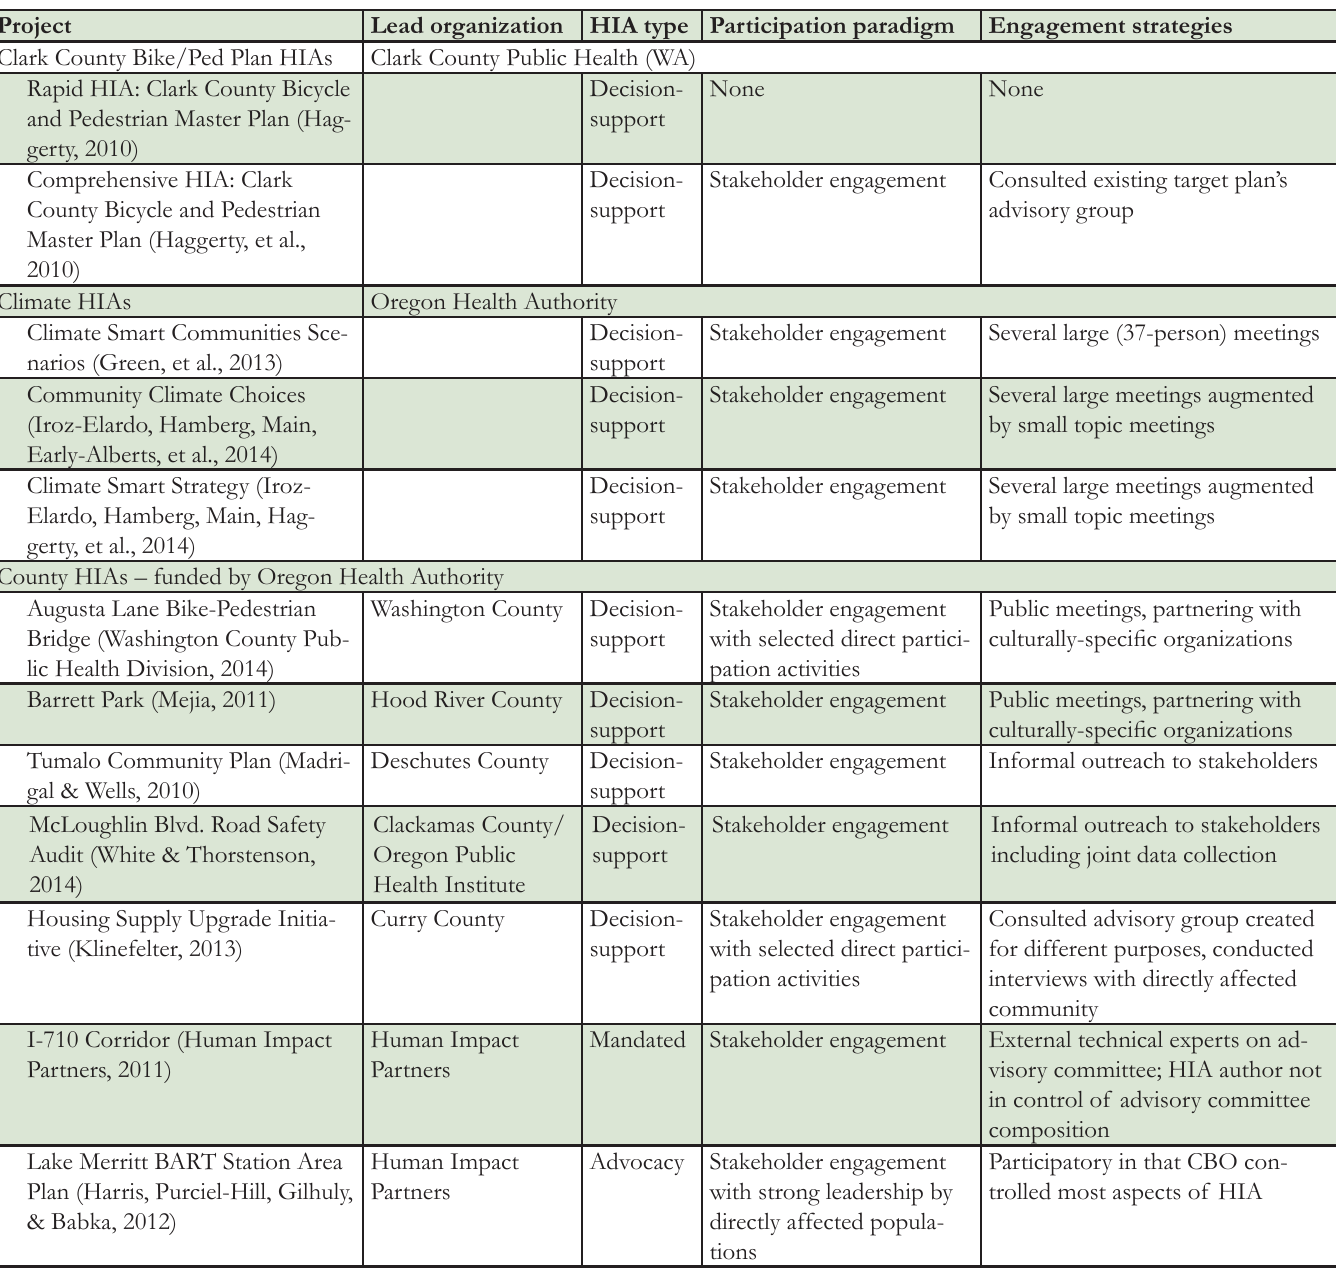
Table 3: Overview of cases